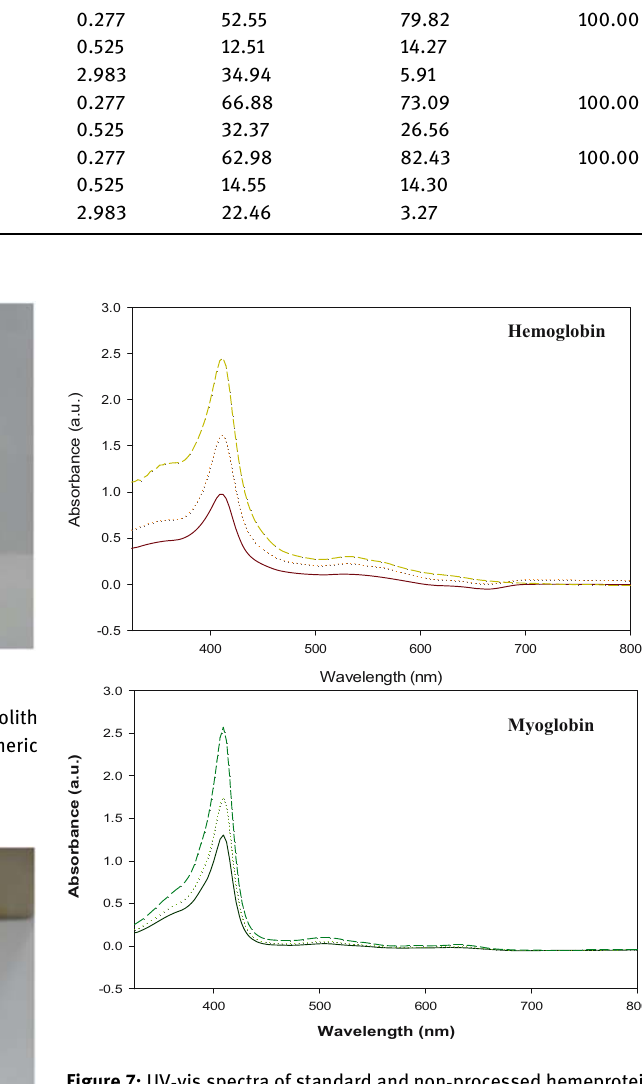
Figure 7: UV - vis spectra of standard and non - processed hemeprotein ( solid line ) , and after preconcentration using organic - based mono - lith ( dotted line ) , or using AgStNP – methacrylate polymeric monolith ( dashed line )